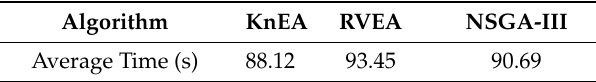
Table 3. Average times of each algorithm.